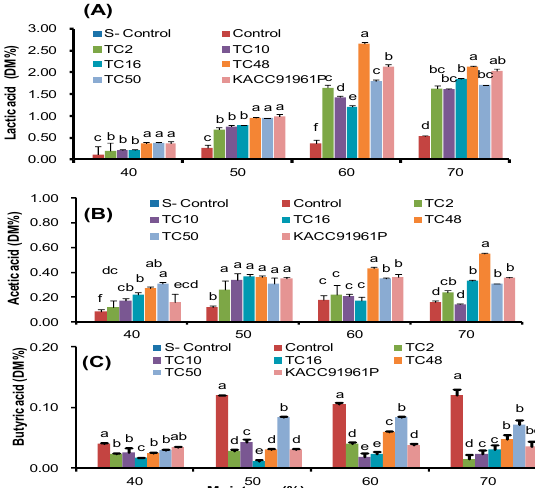
Figure 1. Fermentative metabolites profile of experimental silages at di ff erent moistures.Percentage of lactic acid ( A ), acetic acid ( B ) and butyric acid ( C ) in fermented silages quantified by HPLC.S - Control: Sterilized with ethylene oxide gas, DM: Dry matter. Data were represented as mean of standard deviation (mean ± STD, n = 5); a, b, c, d, e and f Means with di ff erent letters within a column are significantly di ff erent at the 5% level.